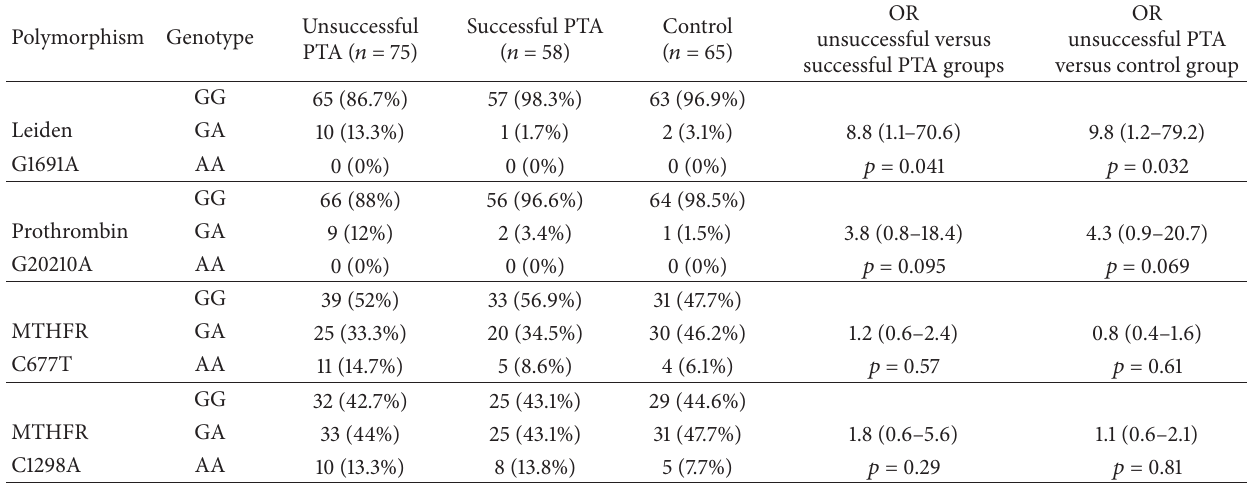
Table 3: Genotype frequencies with odds